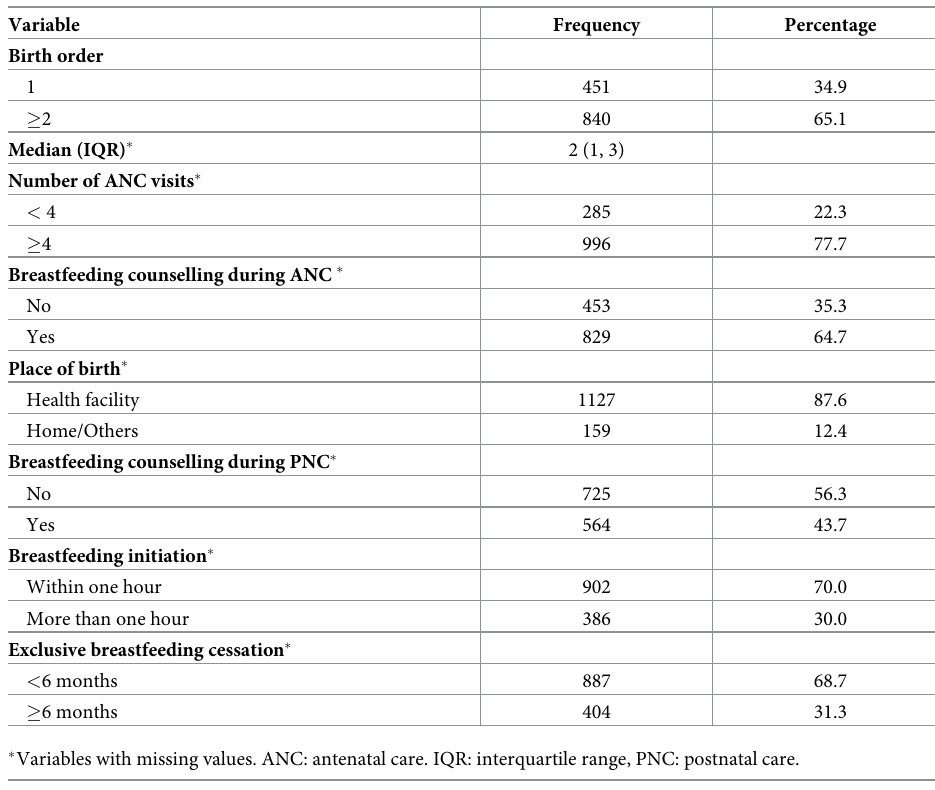
Table 3. Reproductive characteristics and breastfeeding practices (N = 1291).